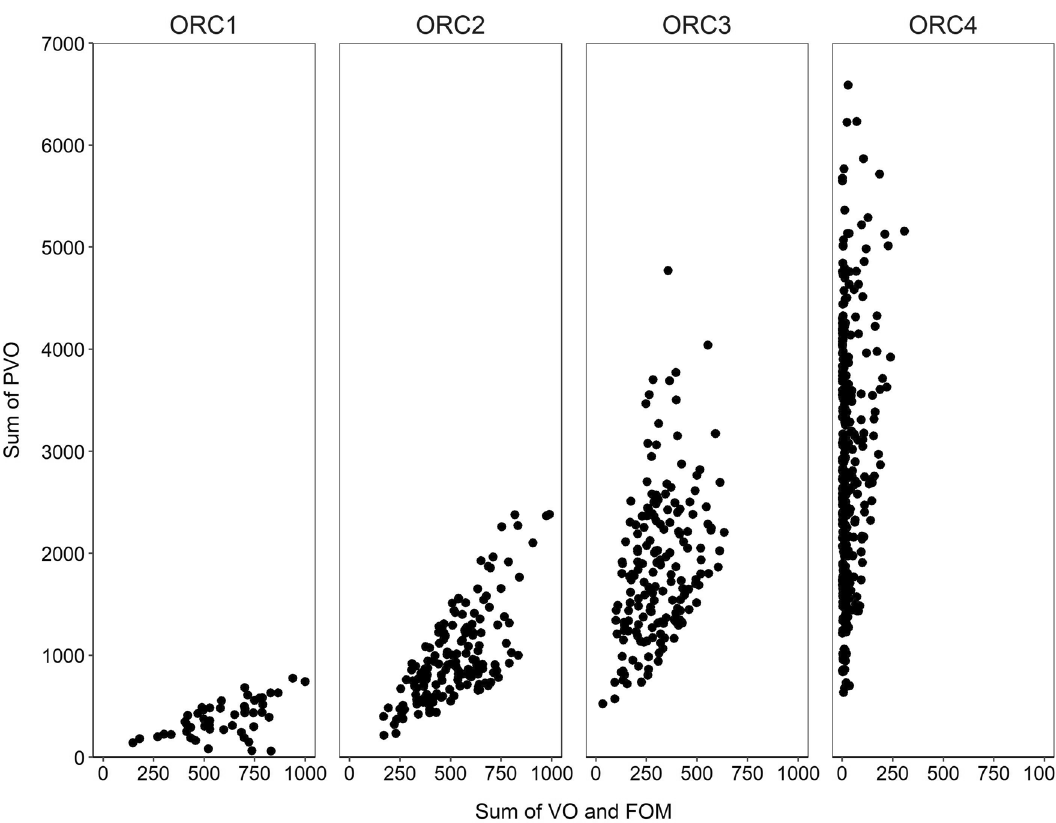
Figure 1. Wholemount counts of previtellogenic (PVO) versus developing oocytes (VO and FOM) used within the ultrametric method to categorize the “stage of spawning” represented by the oocyte ratio category (ORC). The resulting ORC category (ORC1-4) is showed above each panel. VOs includes cortical alveoli oocytes.